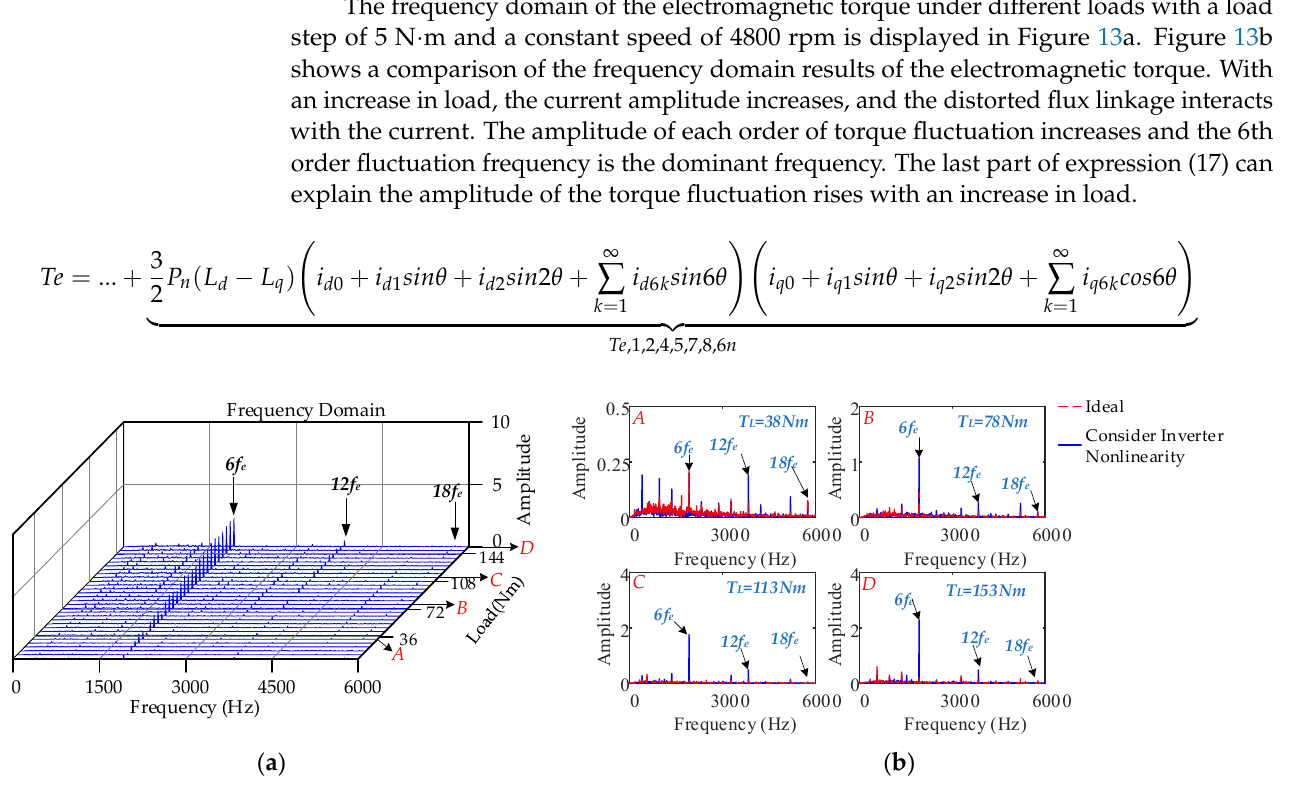
Figure 13. Frequency domain results of electromagnetic torque under different loads: ( a ) waterfall diagram of electromagnetic torque; ( b ) comparison results of electromagnetic